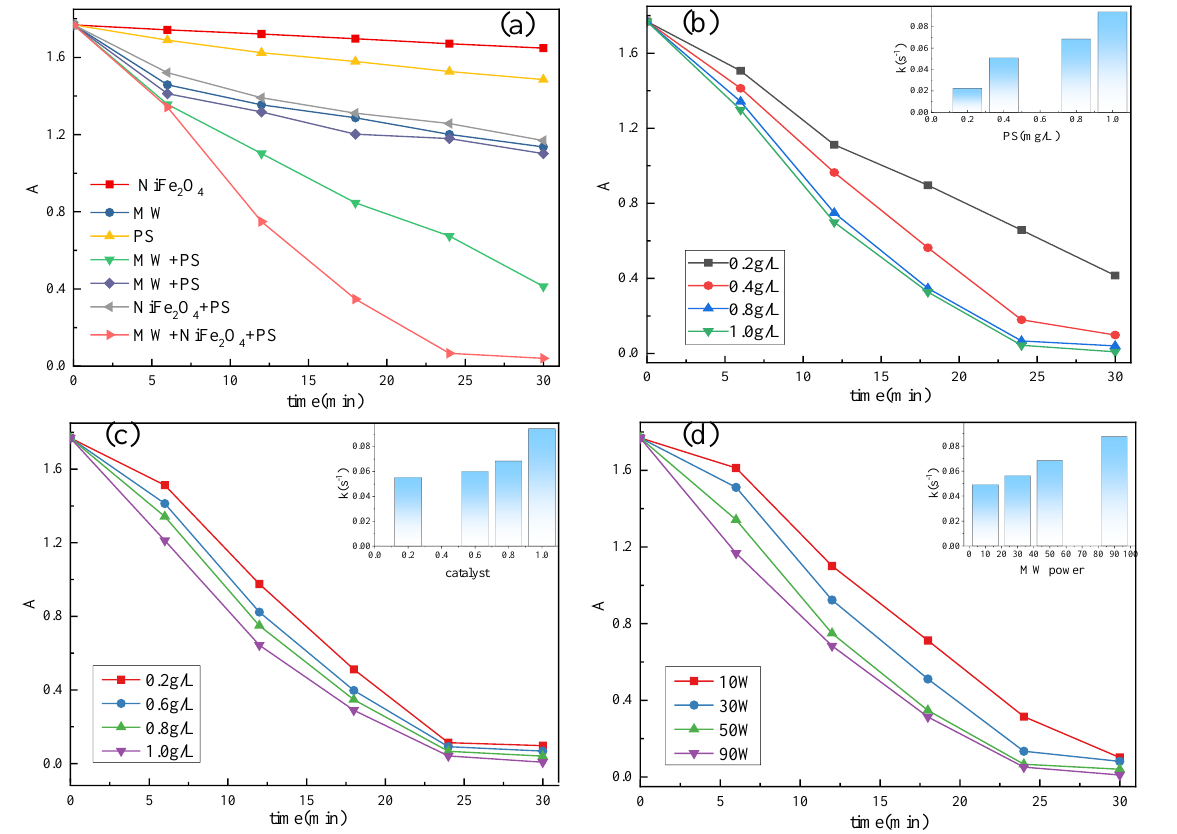
Figure 3. Degradation of phenol in solution under various reaction system ( a ), PS concentration ( b ), catalyst dosage ( c ), and MW power ( d ) (Reaction conditions: PS concentration = 0.4 g/L, catalyst dosage = 0.6 g/L, phenol concentration = 0.01 g/L, reaction temperature= 25 °C and initial pH value = 6.5 (unadjusted)).